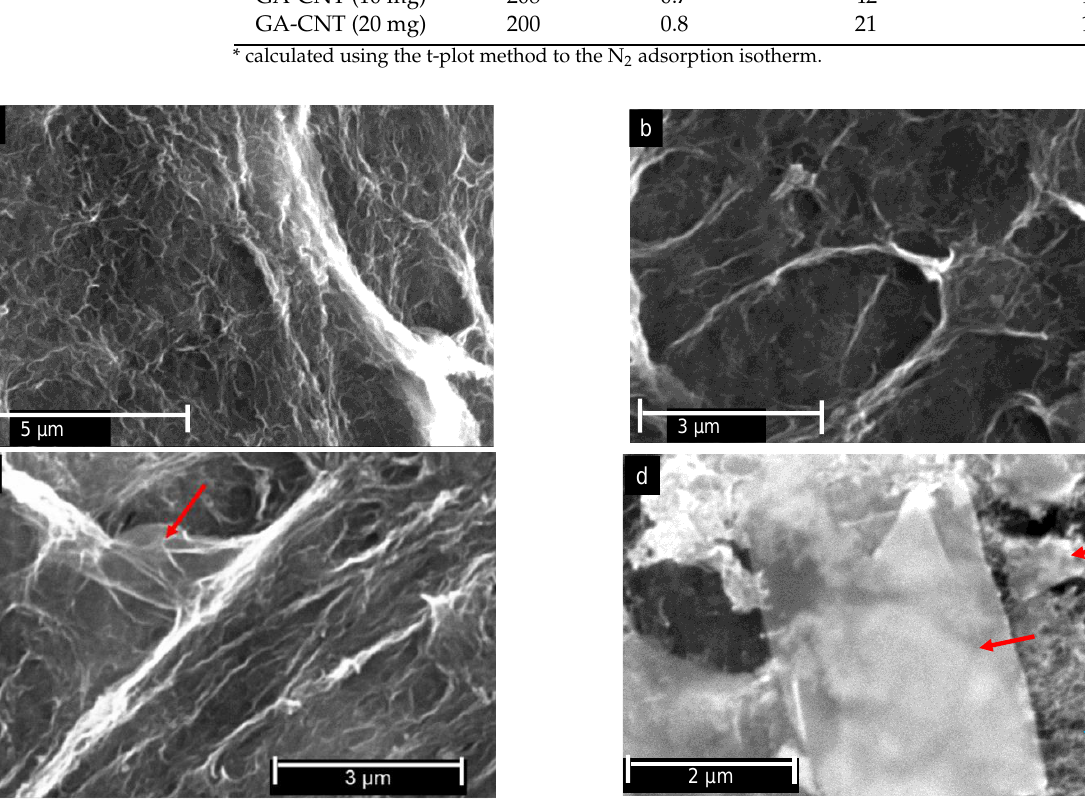
Figure 3. Representative SEM images of GA_700 ( a , b ) and GA-CNT(20 mg)_700 ( c , d ). Red arrows point to graphene sheets and blue arrow to an area of entangled CNT.